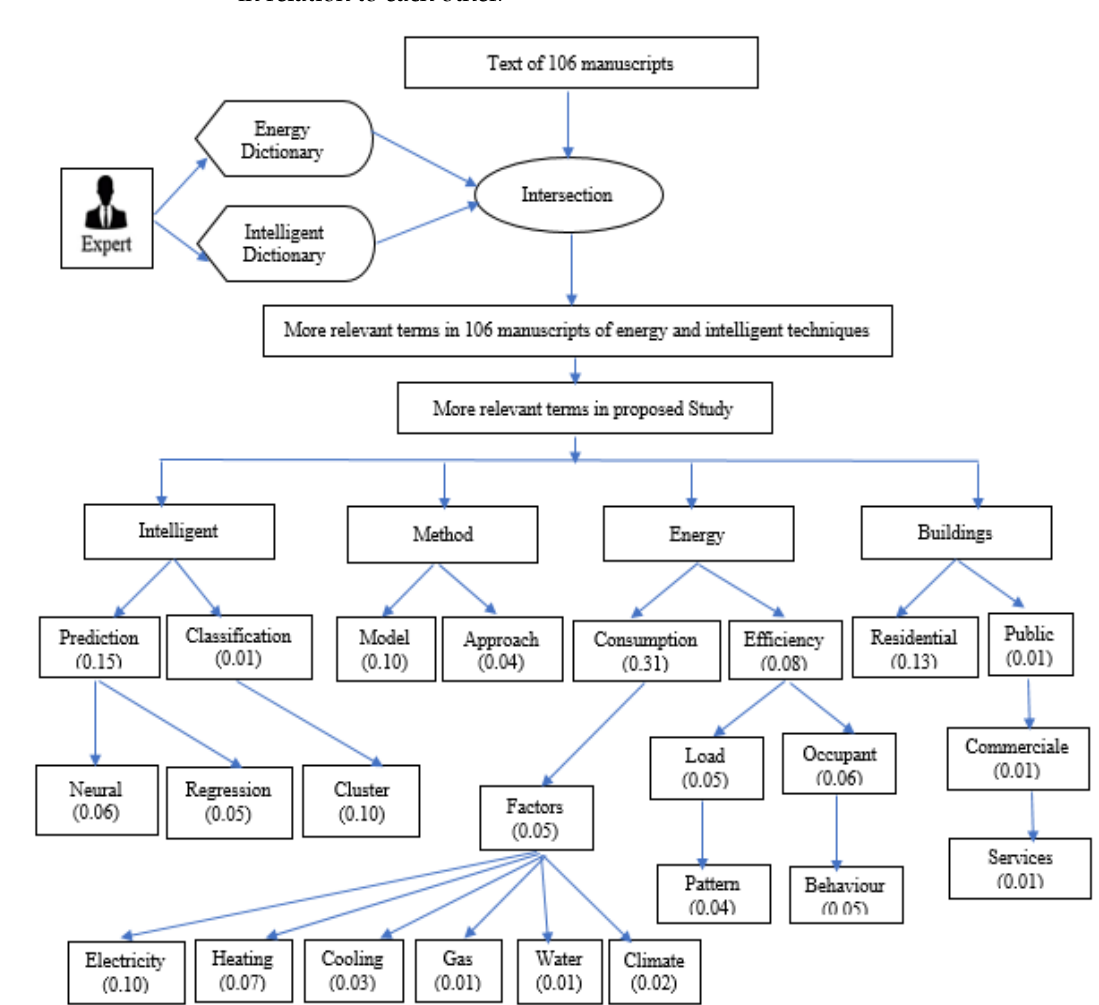
Figure 6. General steps for obtaining highly relevant terms in our corpus. The numbers represent the computed TITs of the terms. Note: if (TITs) > 0.05, the term is relevant.